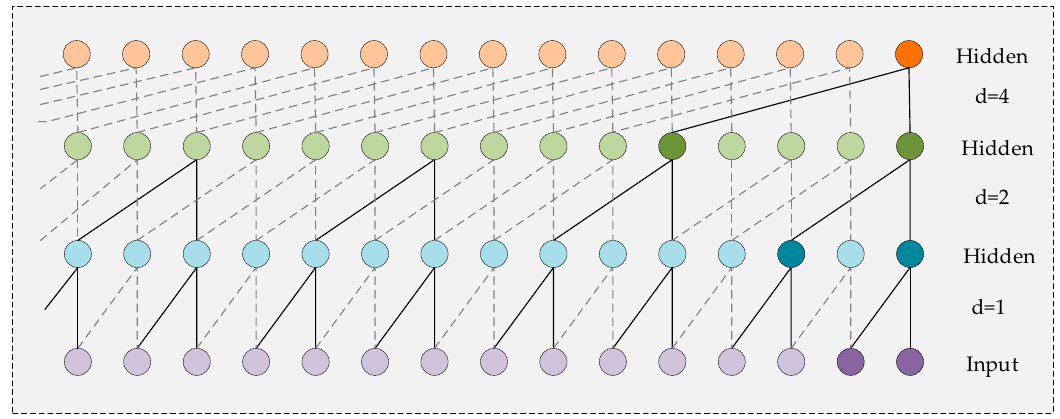
Figure 4. Dilated causal